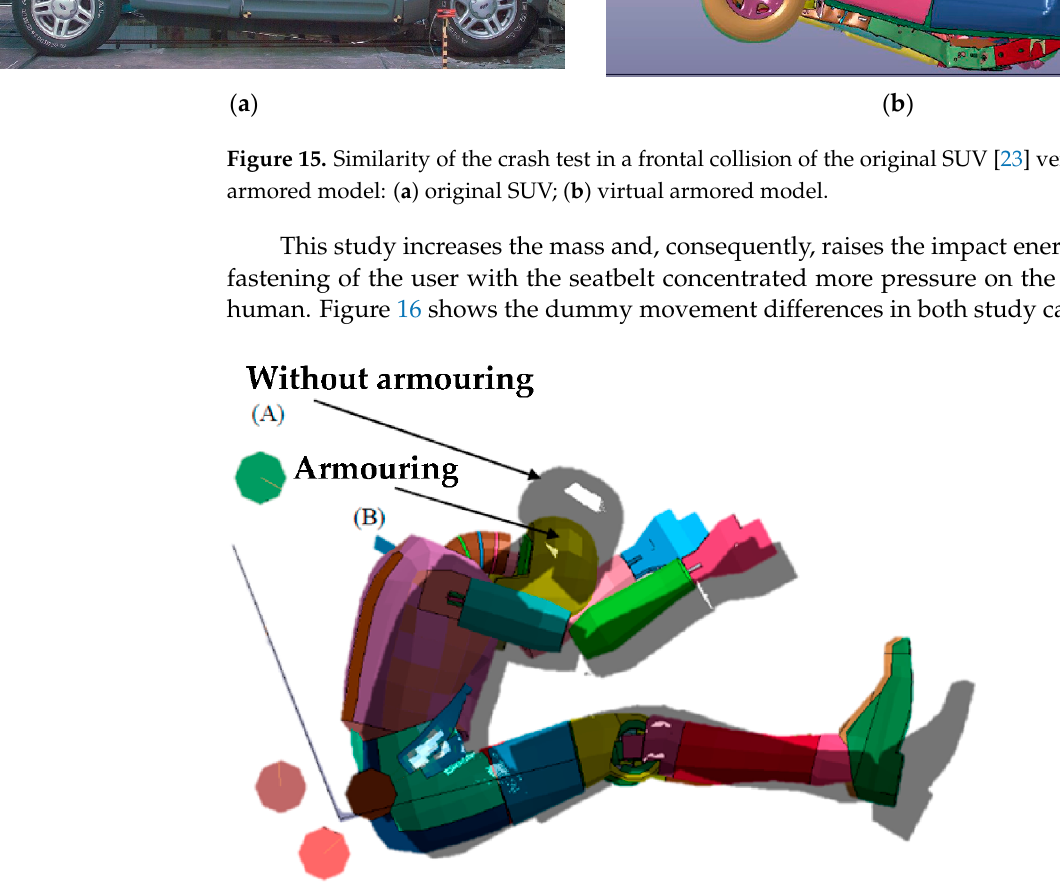
Figure 16. Dummy kinematic in a frontal collision (A) unshielded SUV speed vs. (B) armored SUV speed.